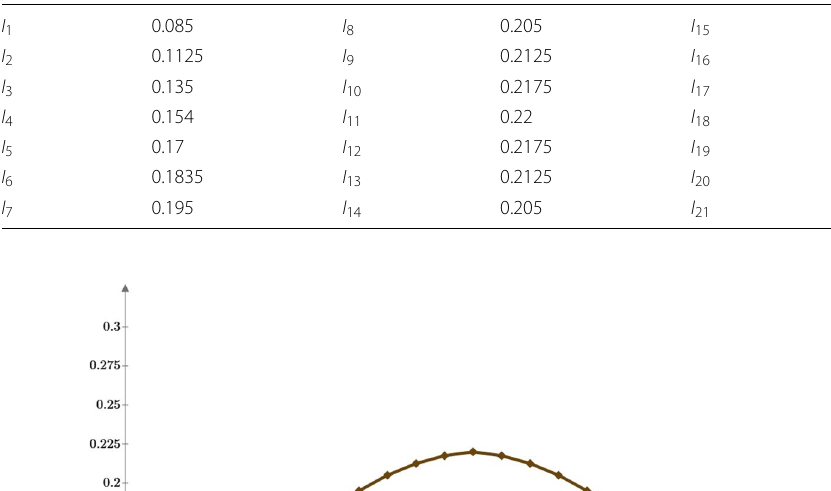
Table 1 Given amplitude distribution for N = 21 transversely radiating antenna I n